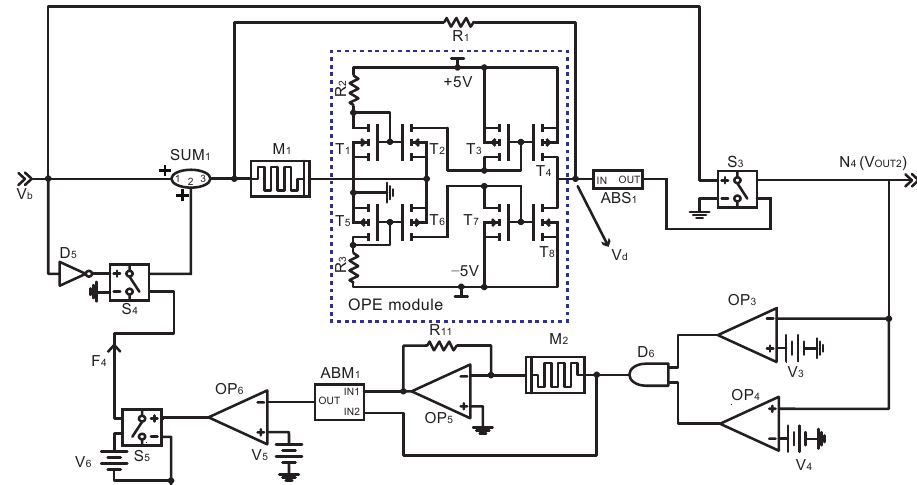
Figure 8. Sensitization module. F 4 is feedback signal. S 3 , S 4 , and S 5 are the voltage-controlled switches. The closed voltage of S 5 is 2 V. The closed voltage of S 3 is 0.9 V. The closed voltage of S 4 is 2 V. R 1 = 1 k Ω , R 11 = 100 Ω , V 3 = 3.5 V, V 4 = 2 V.